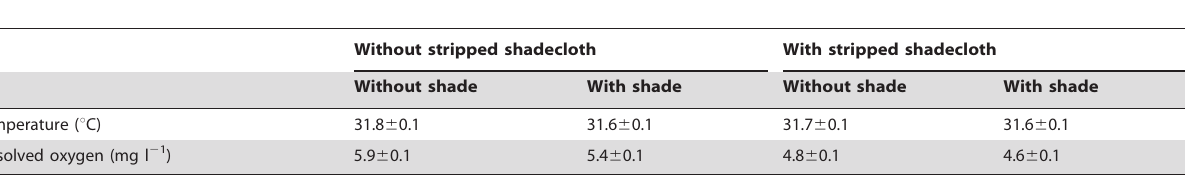
Table 1. Average water parameters in fine-mesh enclosures within the pond in the first experiment ( Effects of increasing mesh surfaces and shading ).